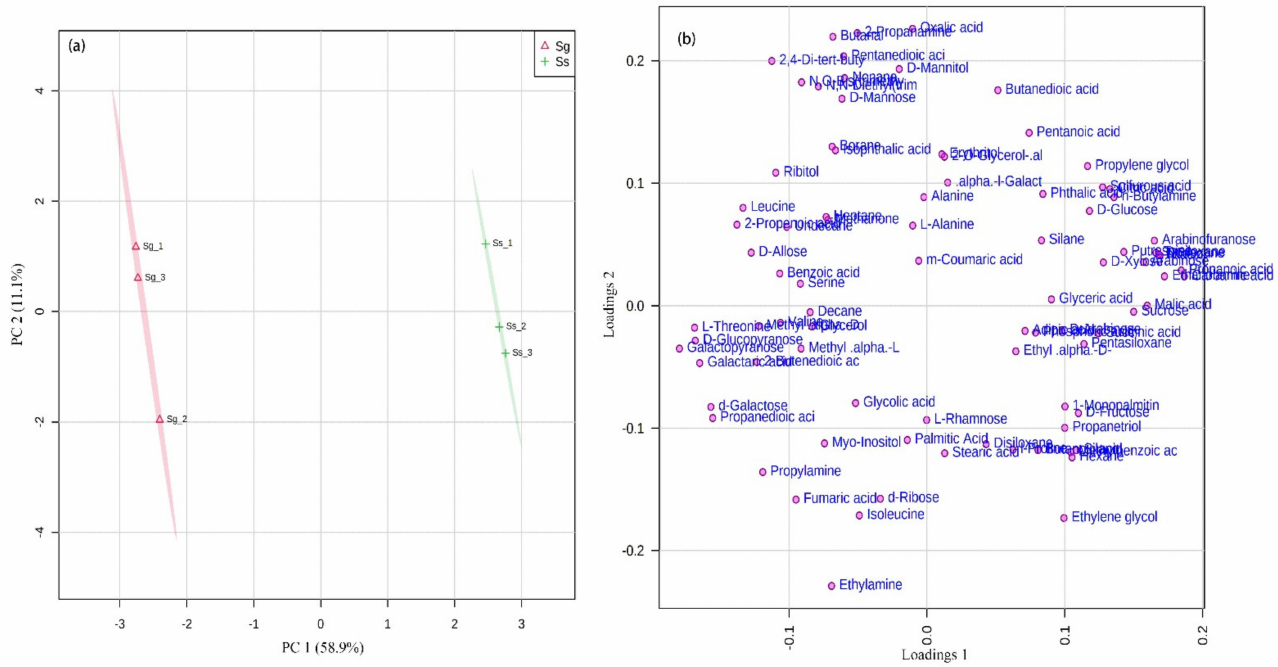
Figure 2. Multivariate analysis of metabolites between S. glauca and S. salsa leaves. ( a ): PLS-DA score plot for leaves; ( b ): PLS-DA loading plot for leaves. Sg: S. glauca ; Ss: S. salsa